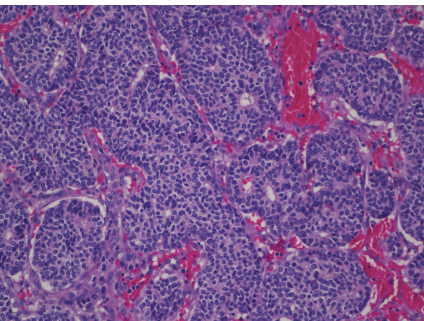
Figure 1: Light microscopy shows monomorphous round cells with salt-and-pepper chromatin arranged mostly in nests with a cribriform pattern that formed rosette-like structures (hematoxylin and eosin stain, original magnification × 20).